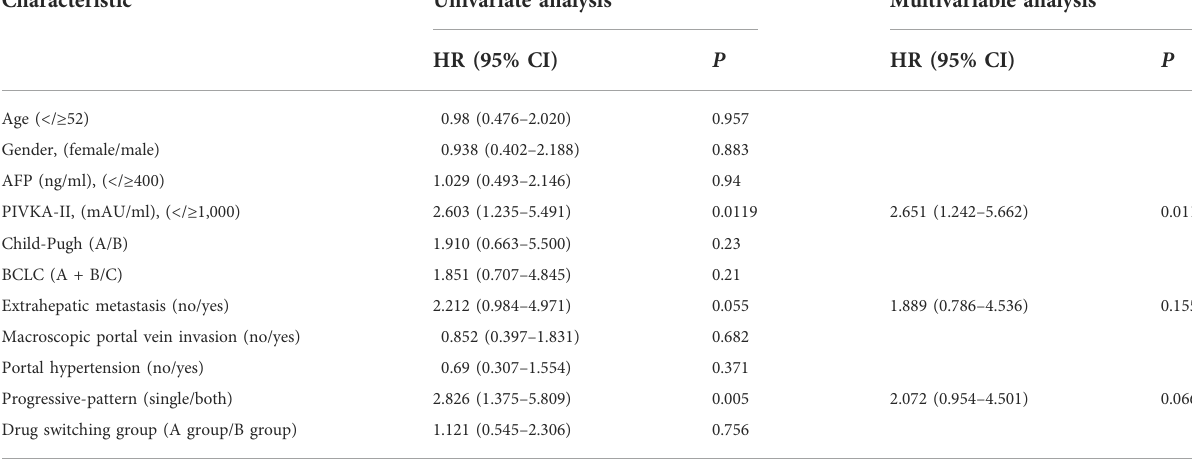
TABLE 7 Univariable and multivariable Cox regression analyses for overall survival.